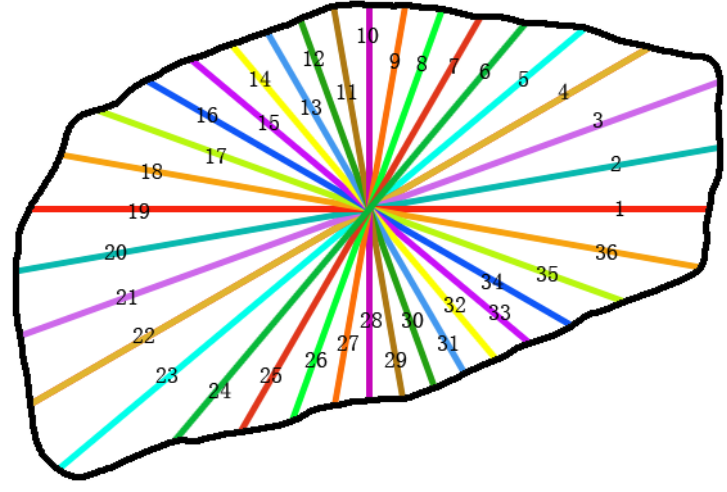
Figure 2. Triangle area divisions for measurement.